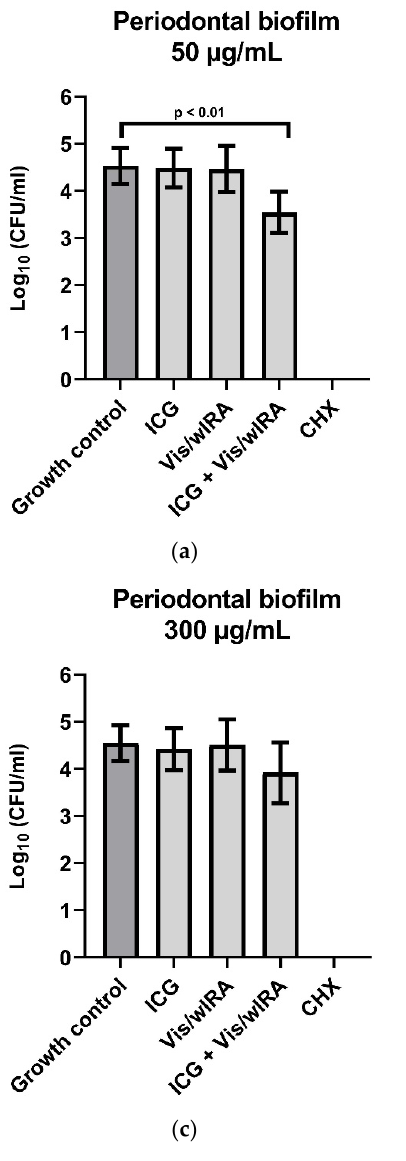
Figure 4. Photodynamic efficacy of ICG in combination with Vis + wIRA on periodontal biofilm. ICG was tested in concentrations of ( a ) 50 µg/mL, ( b ) 150 µg/mL, ( c ) 300 µg/mL, and ( d ) 500 µg/mL. The CFU numbers are given on a log 10 scale per milliliter (log 10 CFU/mL). 3.3. Vis + wIRA in Combination with ICG Affects the Cell Viability of Human Gingival Keratinocytes In Vitro Vis + wIRA alone does not affect cell viability at room temperature (RT) or at 37 °C after 5 min, 10 min, or 20 min. Only after 10 min Vis + wIRA at 37 °C is a significant in- crease of metabolic activity (by 11%) measurable. Figure 5a–d shows that 50 µg/mL ICG significantly reduces keratinocyte metabolic activity by 16% after 5 min, by 12% after 10 min, and not significantly by 6% after 20 min incubation compared to the growth control (Figure 5a). ICG alone at concentrations of 150 µg/mL, 300 µg/mL, and 500 µg/mL showed similar trends in cell viability, namely a sig- nificant decrease of cell survival between 14% and 34% (Figure 5b–d), while the highest applied concentration of 500 µg/mL for 10 min led to a reduction of 39% in metabolic